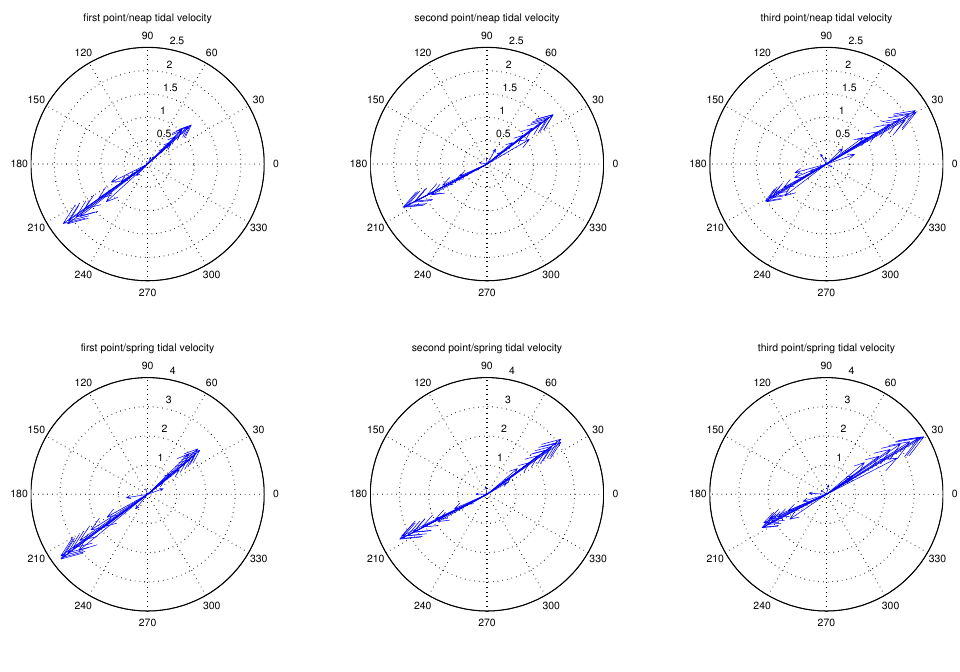
Figure 7. Variations of mean neap and spring tidal velocity vectors at the three considered